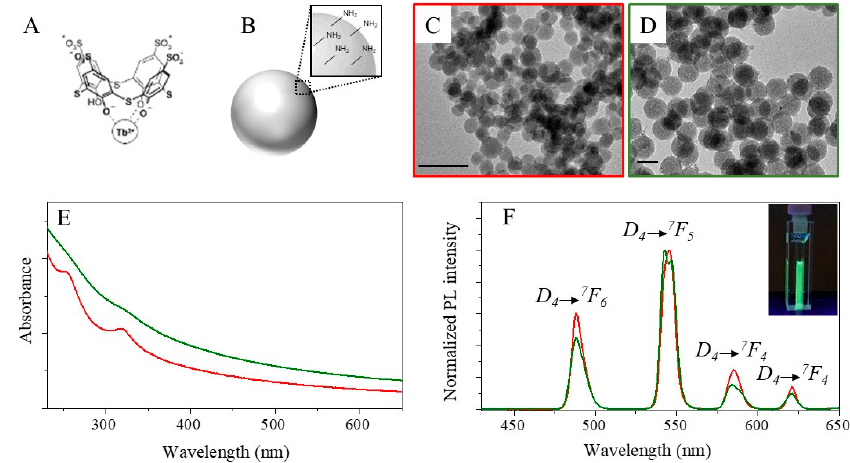
Figure 1. Sketches of Tb III -TCAS complex ( A ) and Tb III -TCAS complex doped silica nanoparticles functionalized with amine groups ( B ). TEM images ( C , D , scar bar 50 nm), ( E ) UV-Vis absorbance and ( F ) fluorescent spectra at excitation wavelength of 330 nm of SN22 ( C , red line in E and F ) and SN46 ( D , green line in E and F9) nanoparticles (NPs).